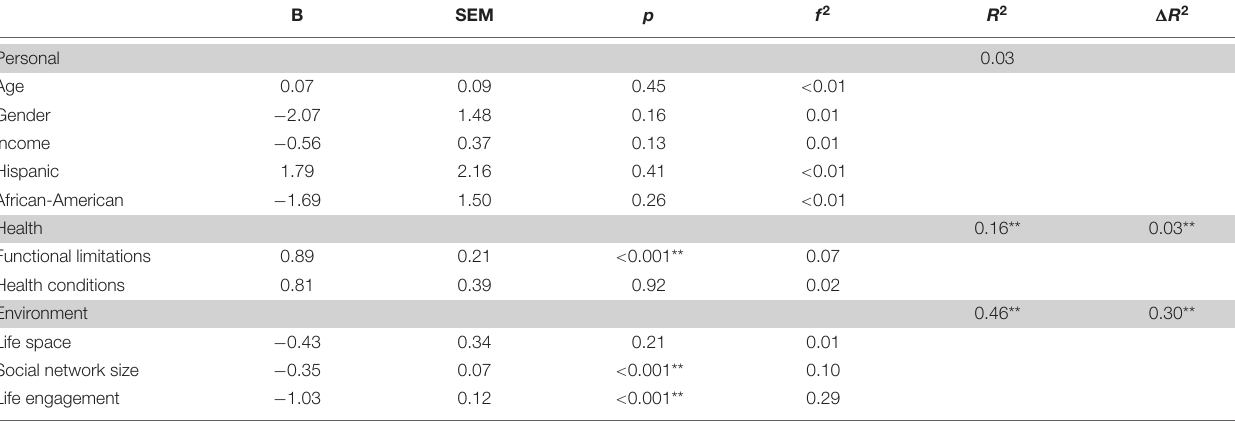
TABLE 7 | Results of hierarchical regression predicting loneliness.